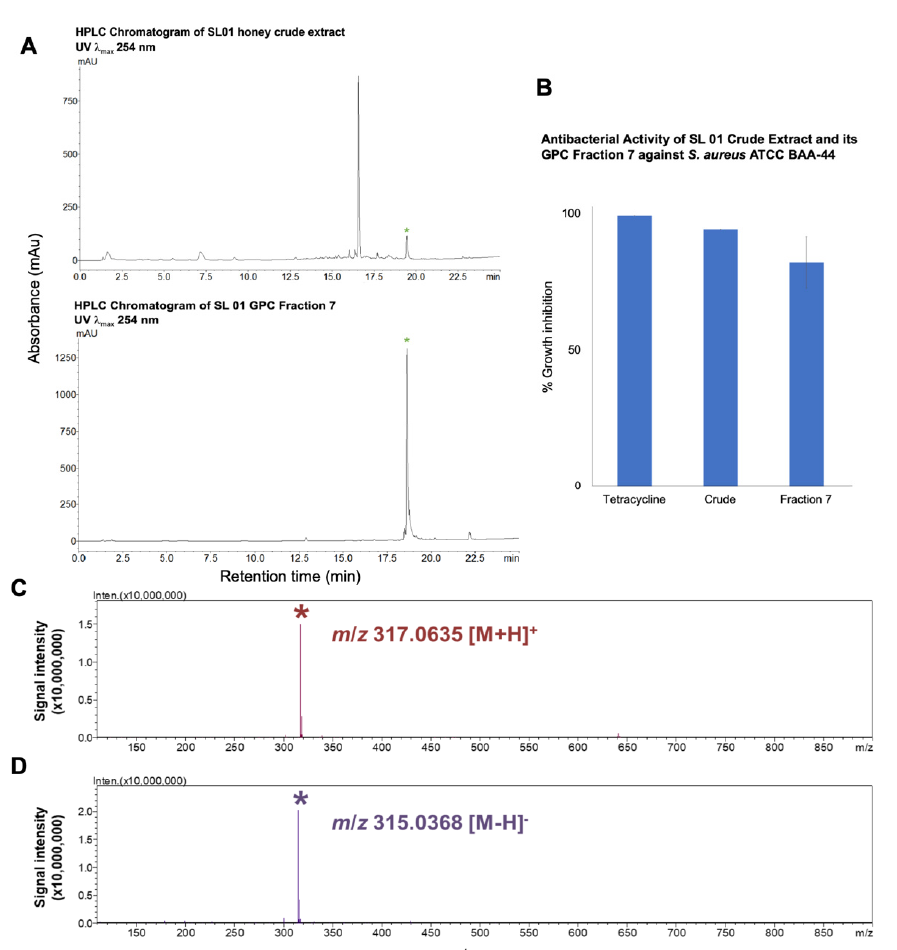
Figure 3. ( A ) High performance liquid chromatography (HPLC) Chromatogram of SL 01 crude extract and GPC fraction 7 showing a peak at λ max 254 nm that eluted at 18.7 min. ( B ) Antibacterial activities of SL 01 honey crude extract and Fraction 7 against S. aureus ATCC BAA-44 at 5 mg/mL; Tetracycline at 0.25 mg/mL as positive control. DMSO showed no inhibitory activity towards S. aureus ATCC BAA-44. LCMS-IT-TOF analysis of peak at 18.7 min showing a measured mass at ( C ) m / z 317.0635 [M + H] + and ( D ) m / z 315.0368 [M − H] − .